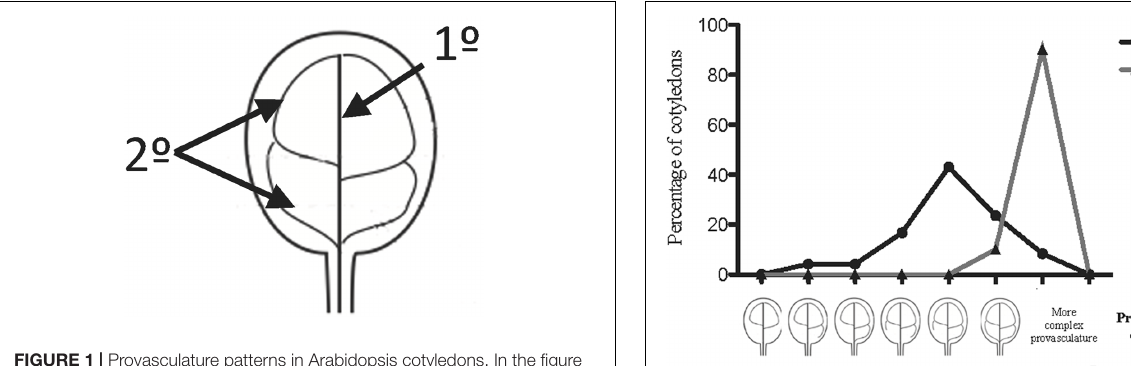
FIGURE 1 | Provasculature patterns in Arabidopsis cotyledons. In the figure 1 ◦ indicates the primary vein and 2 ◦ secondary veins. 1 ◦ and 2 ◦ are forming 4 areoles in this case.